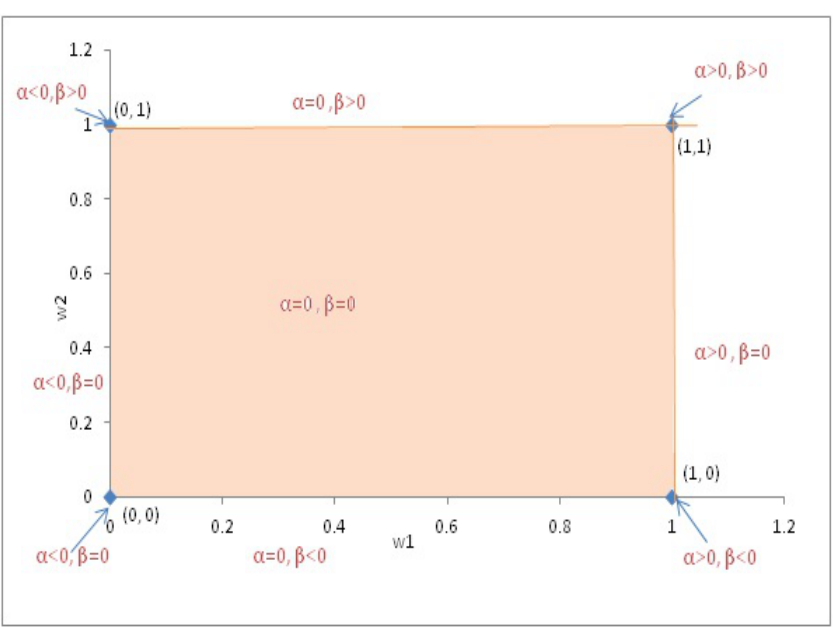
) at any time 𝑤𝑤 2